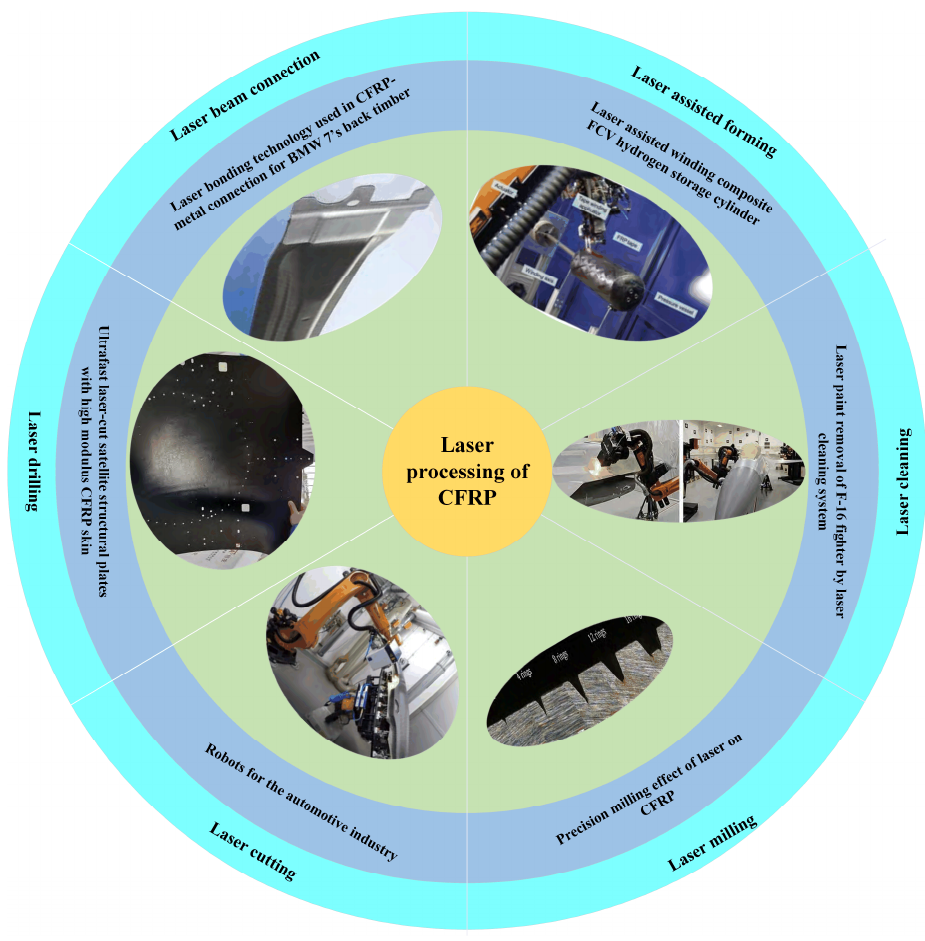
Figure 2. Laser technology used in CFRP